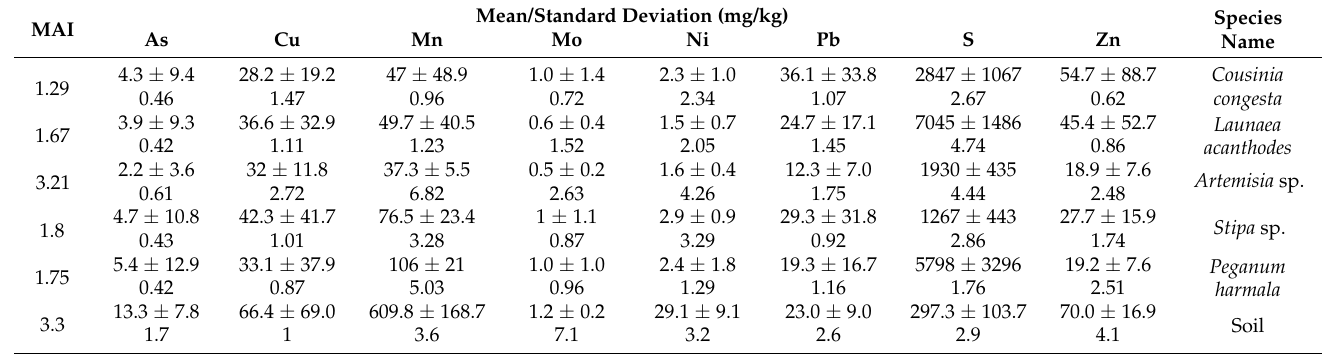
Table 4. Determining the MAI based on the concentration of different elements (mg/kg) in the plant